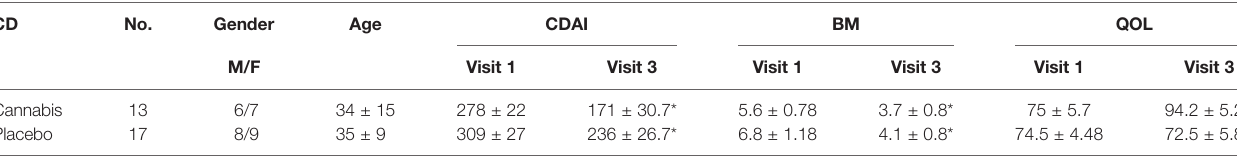
TABLE 4 | Clinical parameters of CD patients.